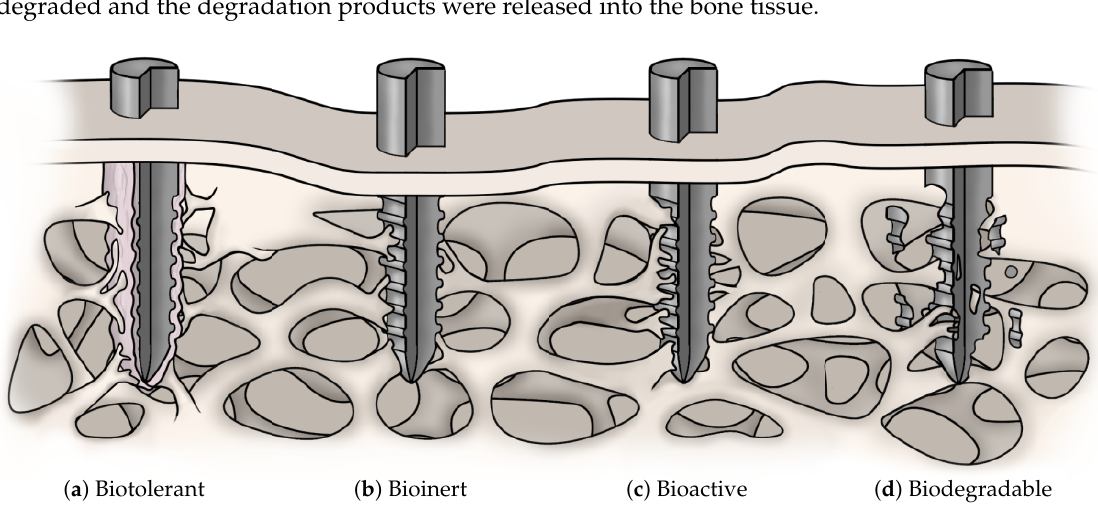
Figure 1. Schematic representation of biomaterial classifications explained using the case of a bone